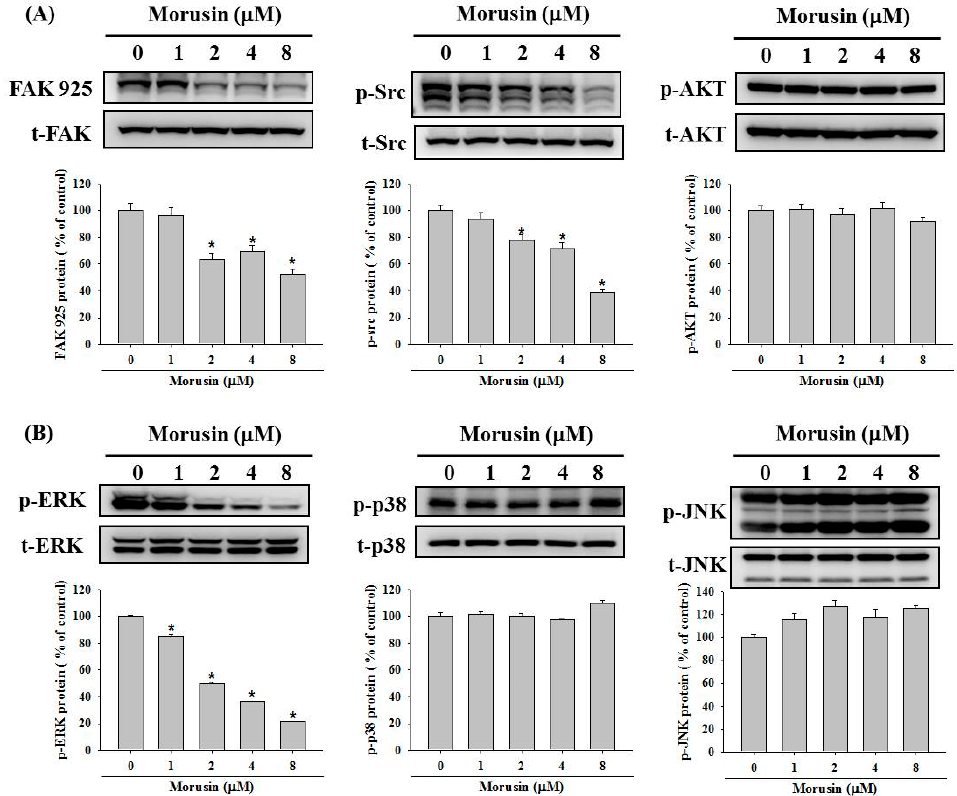
Figure 5. Effect of morusin on regulating the adhesion and MAPK signaling pathways. NPC-39 cells were treated with morusin (0–8 μ M) for 24 h and cell lysates were subjected to Western blotting analysis to analyze the phosphorylation of: FAK, Src, and Akt for adhesion signaling ( A ); and ERK, JNK, and p38 for MAPK pathways ( B ). Densitometric analyses of kinase phosphorylation were conducted by ImageJ. * p < 0.05, compared with the vehicle group.